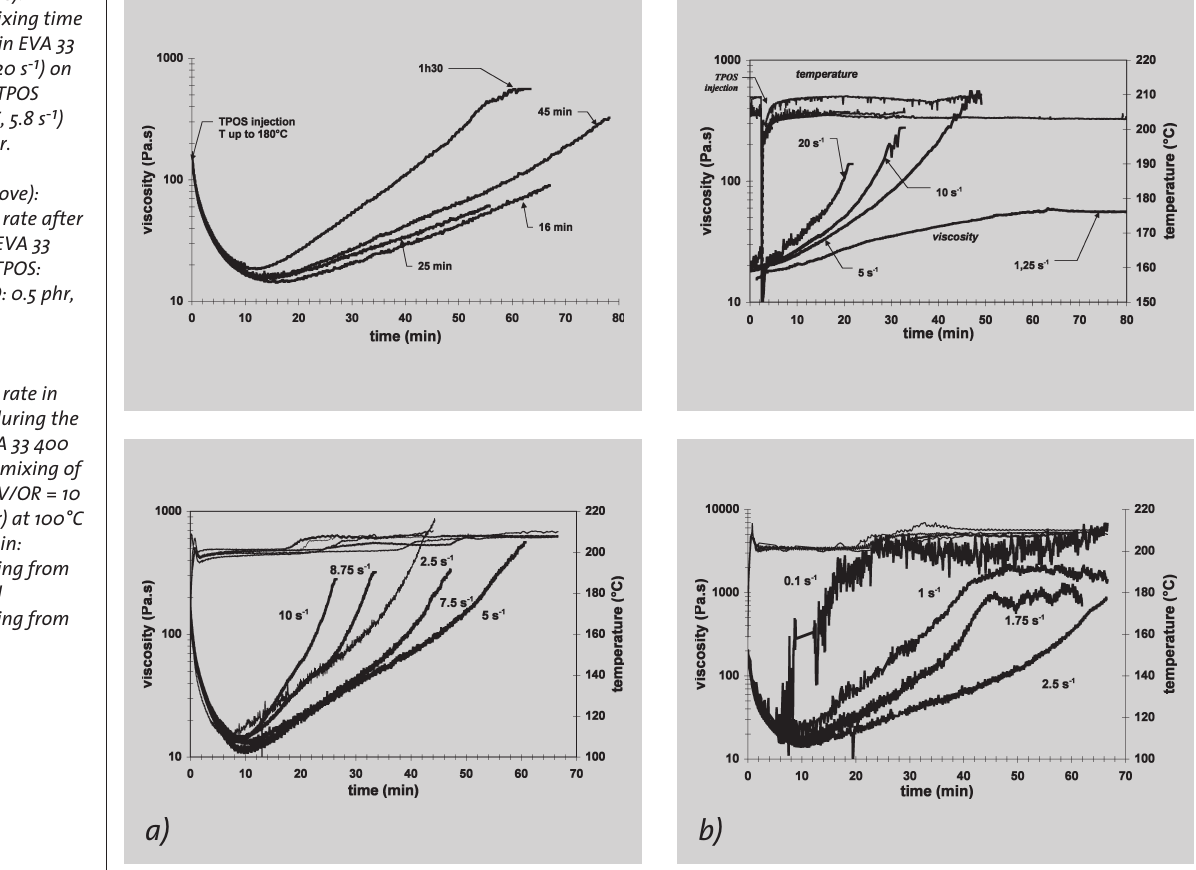
Figure 11 (left above): Influence of premixing time of DBTO (0.5 phr) in EVA 33 400 melt (100°C, 20 s -1 ) on EVA crosslinking (TPOS AV/OR = 10, 180°C, 5.8 s -1 ) in the rheo-reactor. Figure 12 (right above): Influence of shear rate after TPOS injection in EVA 33 400 melt/DBTO (TPOS: AV/OR = 10; DBTO: 0.5 phr, T = 200°C). Figure 13 (below): Influence of shear rate in the rheo-reactor during the crosslinking of EVA 33 400 at 200°C after premixing of reagents (TPOS: AV/OR = 10 and DBTO: 0.5 phr) at 100°C and 20 s -1 for 15 min: a) Shear rate varying from 2.5 to 10 s -1 and b) Shear rate varying from 0.1 to 2.5 s -1